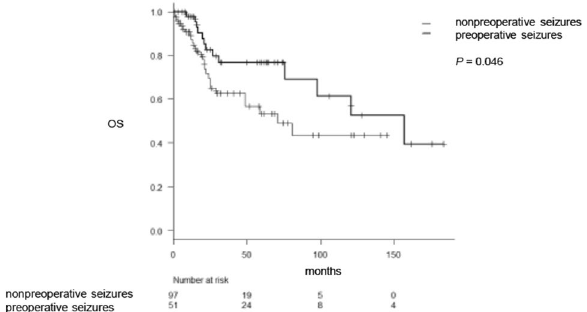
Figure 1. Comparison of survival between patients with preoperative and nonpreoperative seizures in IDH mutant and wild-type gliomas. OS, overall survival.